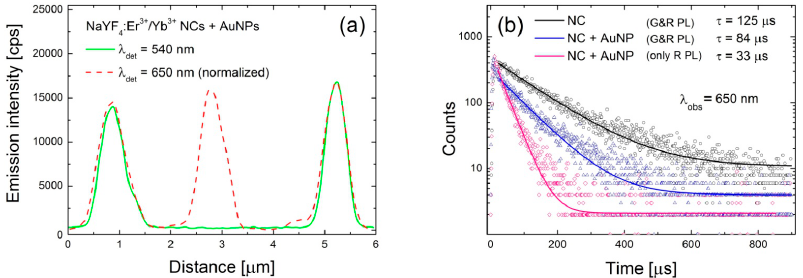
Figure 4. Emission intensity cross-section plotted over CC’ line in Figure 3a,b, acquired for green and red emissions ( a ). Luminescence decay curves of red emission measured for: reference NCs (black line), NCs coupled with AuNPs featuring both emissions (blue line) and NCs coupled with AuNPs featuring red emission and completely quenched green emission (pink line) ( b ).